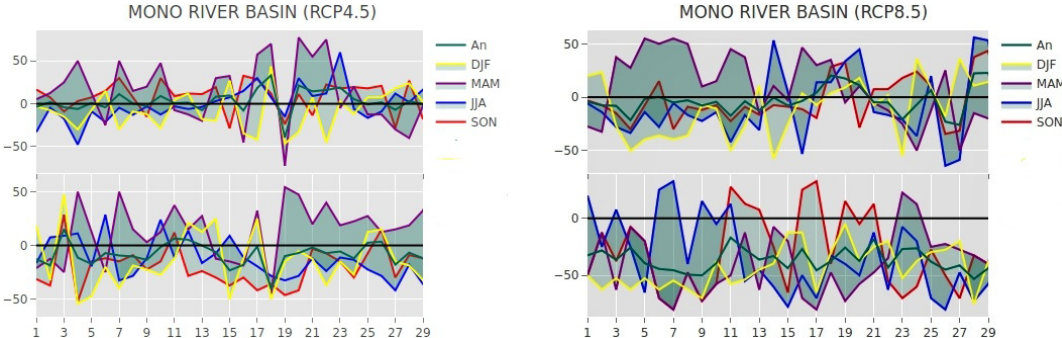
Figure 3. Annual and seasonal changes in streamflows between the futures (2011–2040 in top and 2071–2100 in below) and the historical period (1981–2010) for the average multi-models forced by RCP4.5 and RCP8.5 greenhouse gas scenarios in Mono